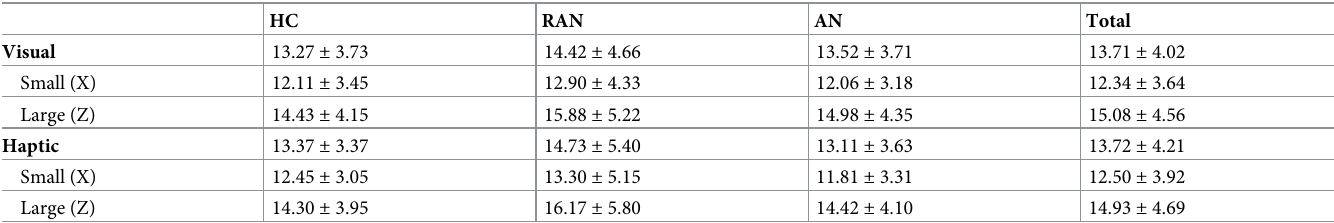
Table 5. Means and standard deviations of grip force peak